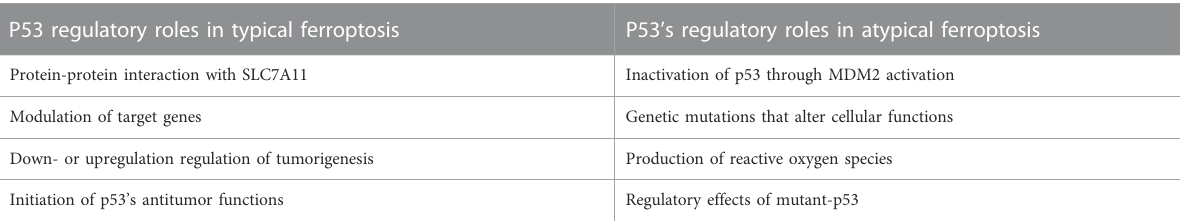
TABLE 6 A summary of p53 ’ s roles in typical and atypical ferroptosis in